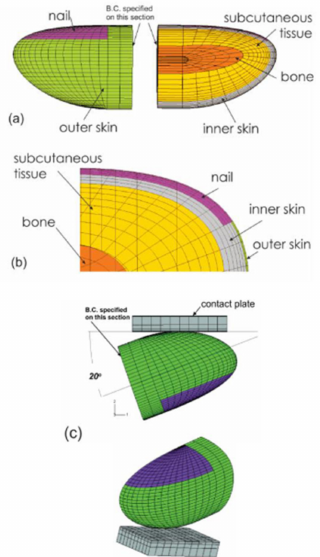
Figure 8. The three-dimensional finite element model of a human fingertip [116,117]. ( a ): External view and longitudinal cross-section. ( b ): Detailed substructures of the model. ( c ): The modelling of the fingertip in contact with a flat